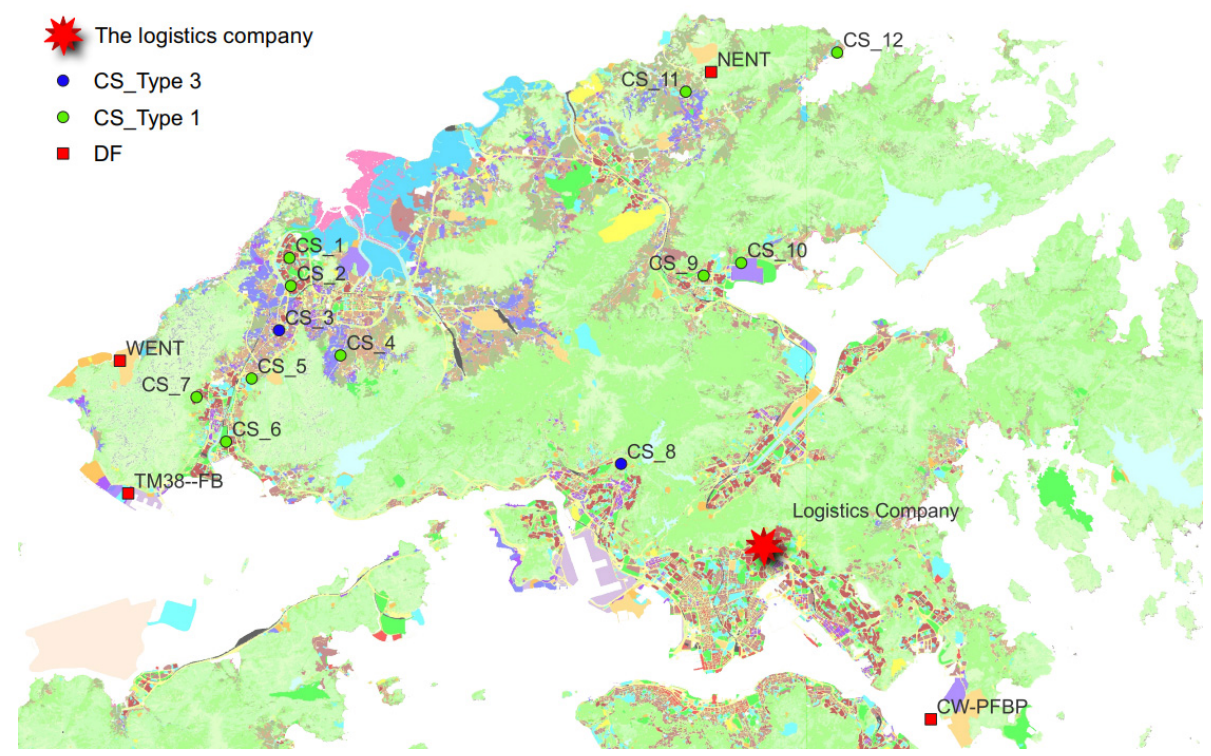
Figure 2. The visualization of the DFs and CSs.